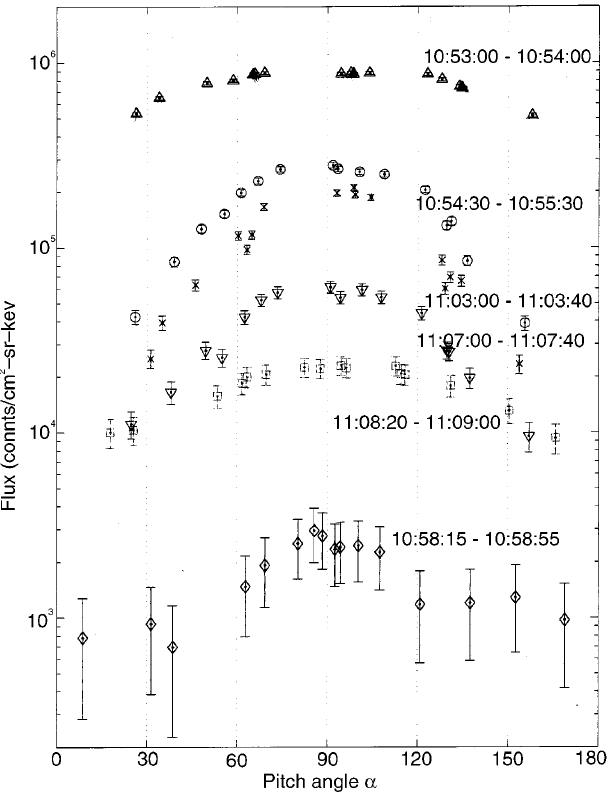
Fig. 4. This plot shows examples of pitch-angle distributions of energetic electrons (20–300 keV) observed in the vicinity of the